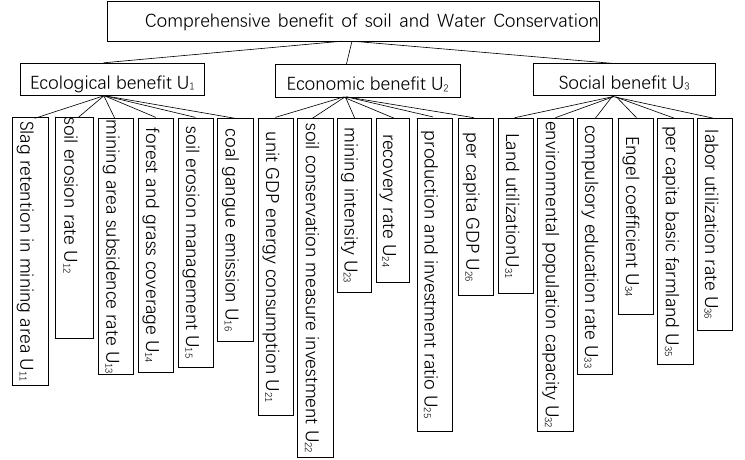
Figure 3. Evaluation to the comprehensive benefits system of soil and water conservation.